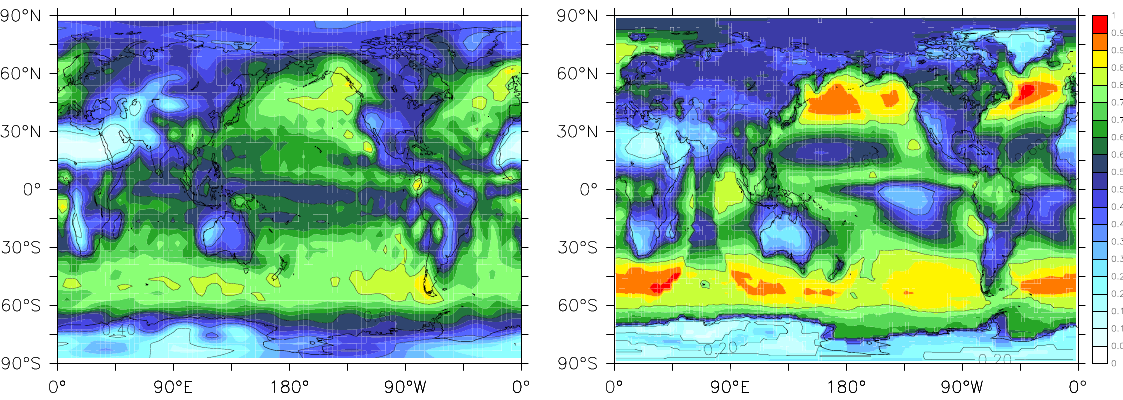
Fig. 6. The annual mean cloud cover fraction for the mean of the SPEEDO ensemble (left) and according to Rossow and Schiffer (1991), (right). Southern Hemisphere falls within the uncertainty in the re- analysis data. The Atlantic heat transport is too low as can be expected from the weak AMOC. The heat transport in the Indo-Pacific shows that the model performs well outside the Atlantic. The model’s internal variability causes the Atlantic heat transport to vary by 0.05